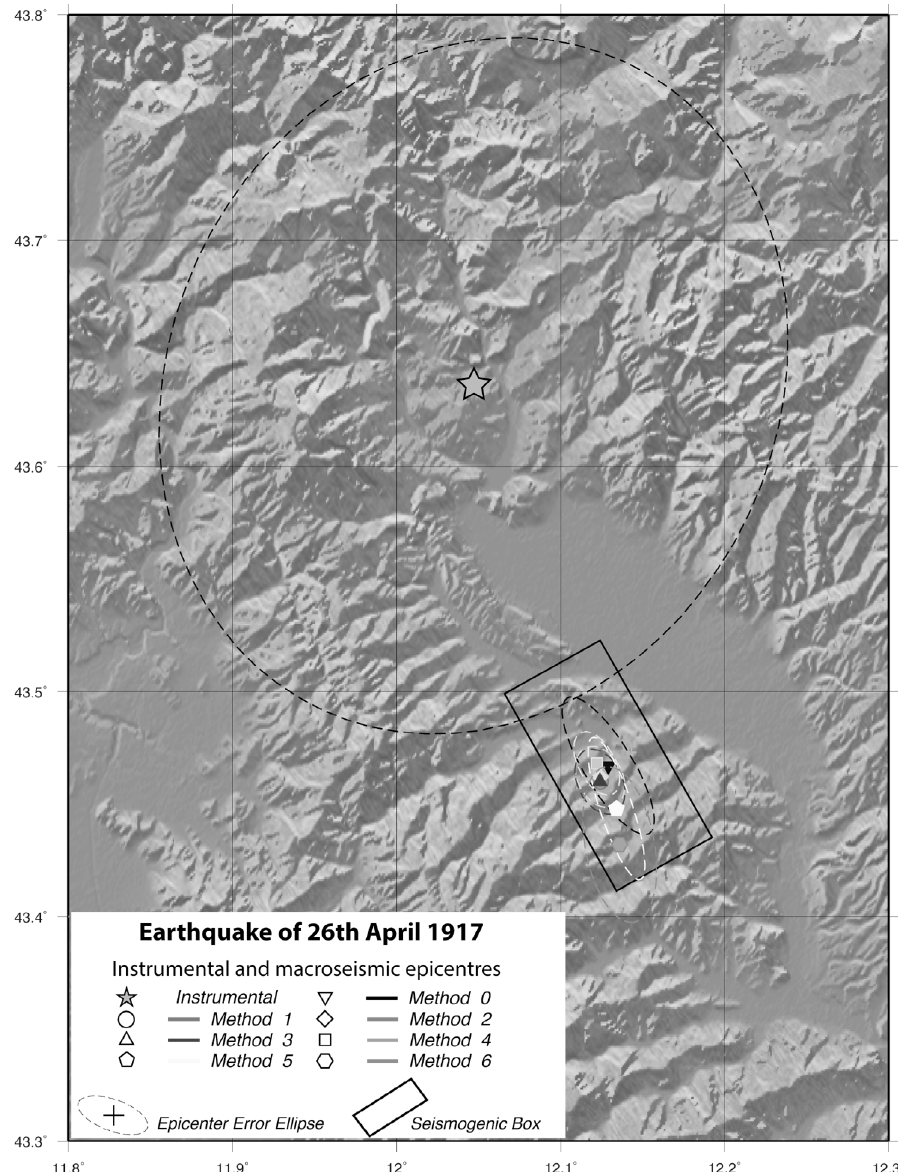
Figure 3. Comparison of the instrumental and macroseismic locations of the epicenter of 1917’s